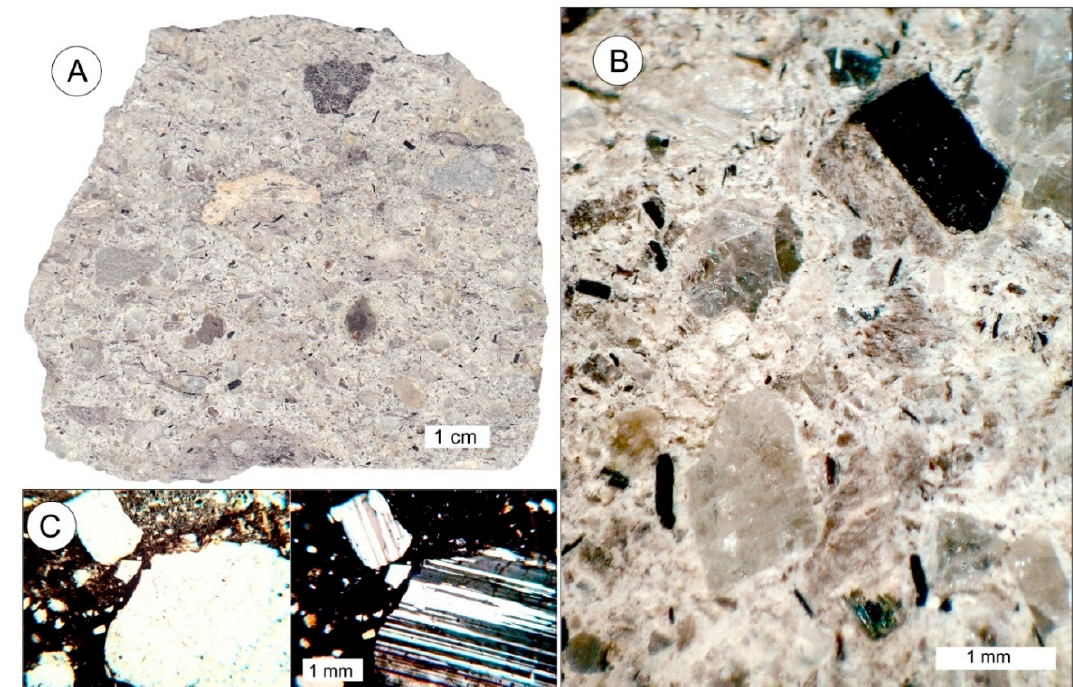
Figure 22. Lithic tuffite. ( A ). Sample S8, from approx. 37 m stratigraphic level. ( B ). Magnified image showing quartz, feldspar, and pyroxene phenocrysts in tuffaceous matrix. ( C ). Sample S6, from 31m stratigraphic level. Plagioclase phenocrysts in tuffaceous matrix. Left photo: ordinary transmitted light. Right photo: transmitted polarized light. The glassy tephra that comprises the matrix is isotropic.